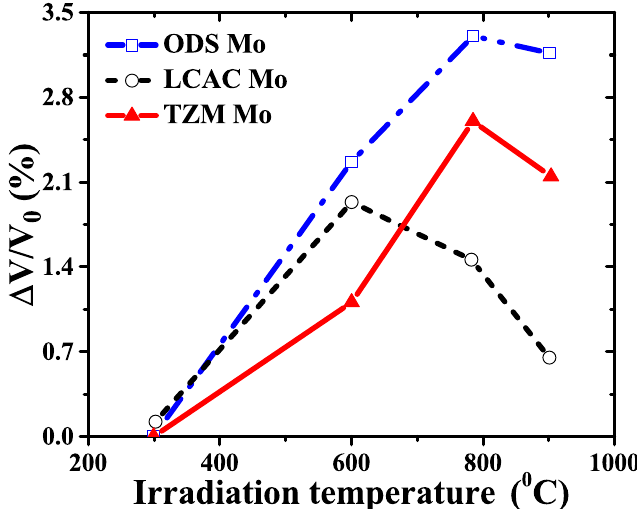
Figure 3. (color online) Maximum swelling as a function of irradiation temperature for oxide dispersion strengthened (ODS), low carbon arc cast (LCAC) and molybdenum-0.5pct titanium-0.1pct zirconium (TZM) molybdenum under highest fluence. (Reprinted with permission from [89]. Copyright 2011 by